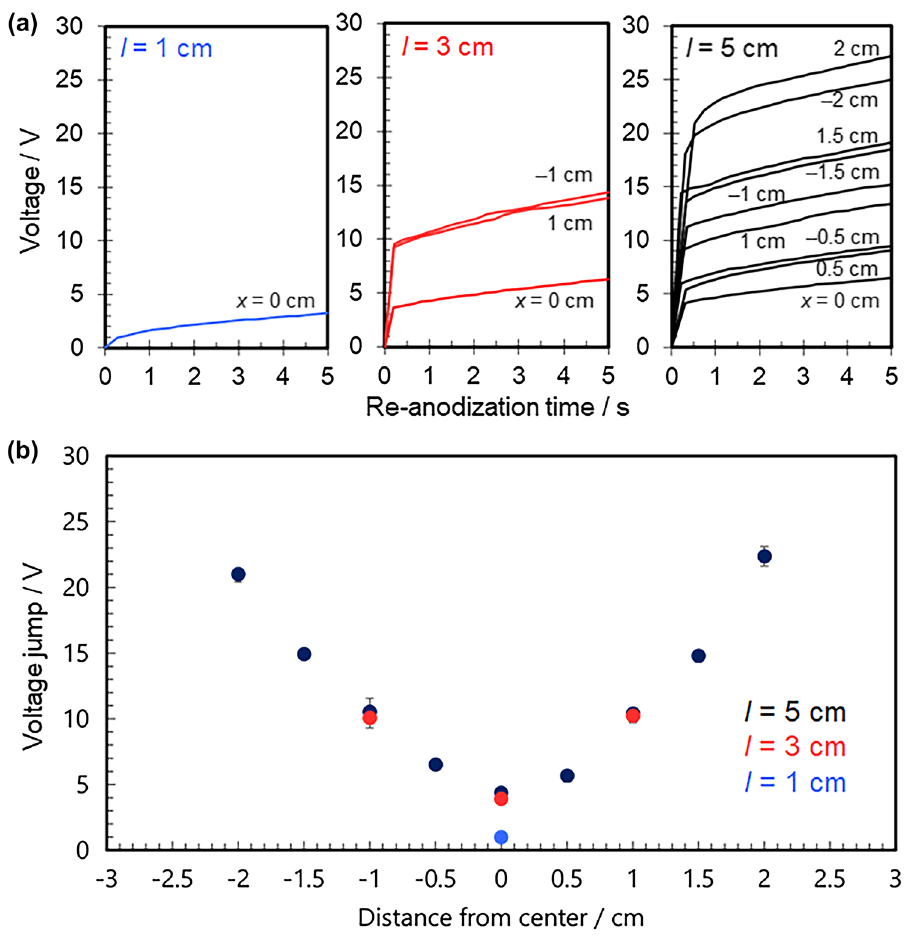
Figure 3. (a) Typical voltage–time curves recorded at different locations on the aluminum specimens during re-anodization and (b) voltage jump ( V j ) plotted as a function of the distance from the center of the BPE. Each reported value for V j is the average of three